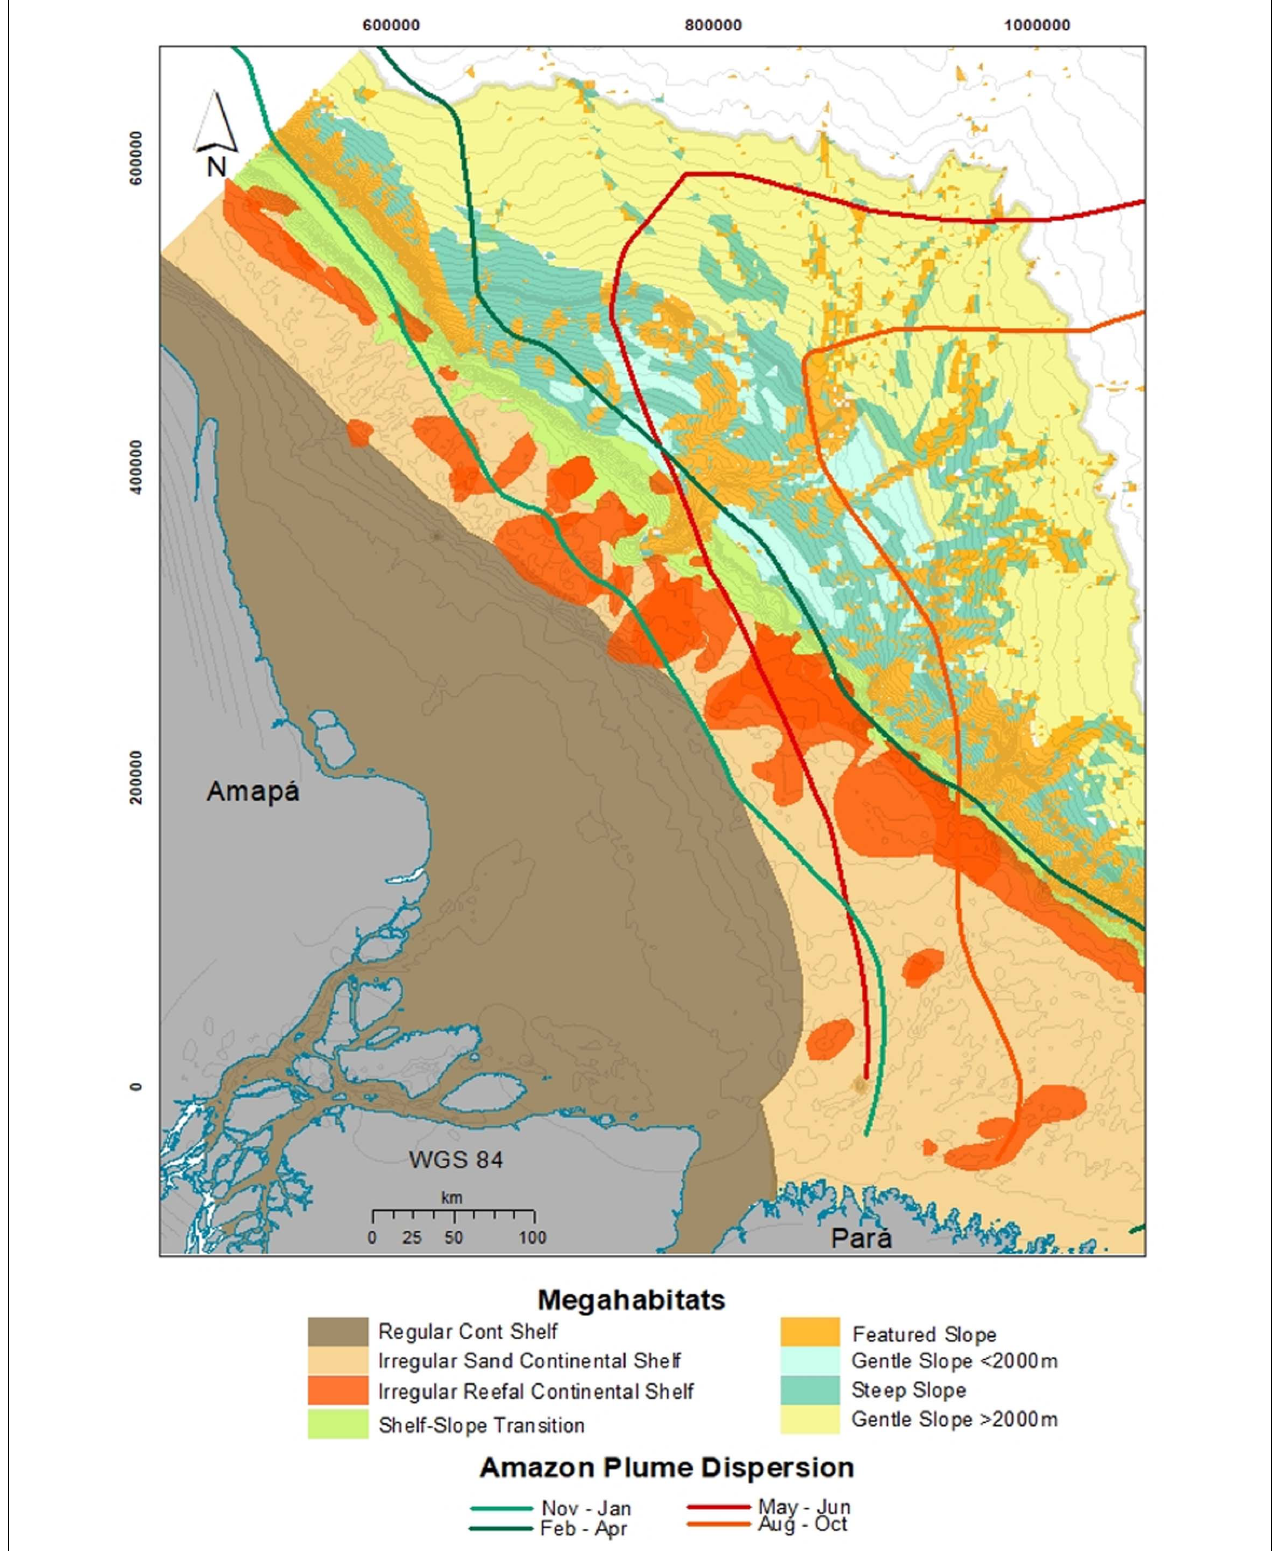
FIGURE 10 | Megahabitats of the Amazon Continental Margin as discriminated by geomorphometric analyzes.